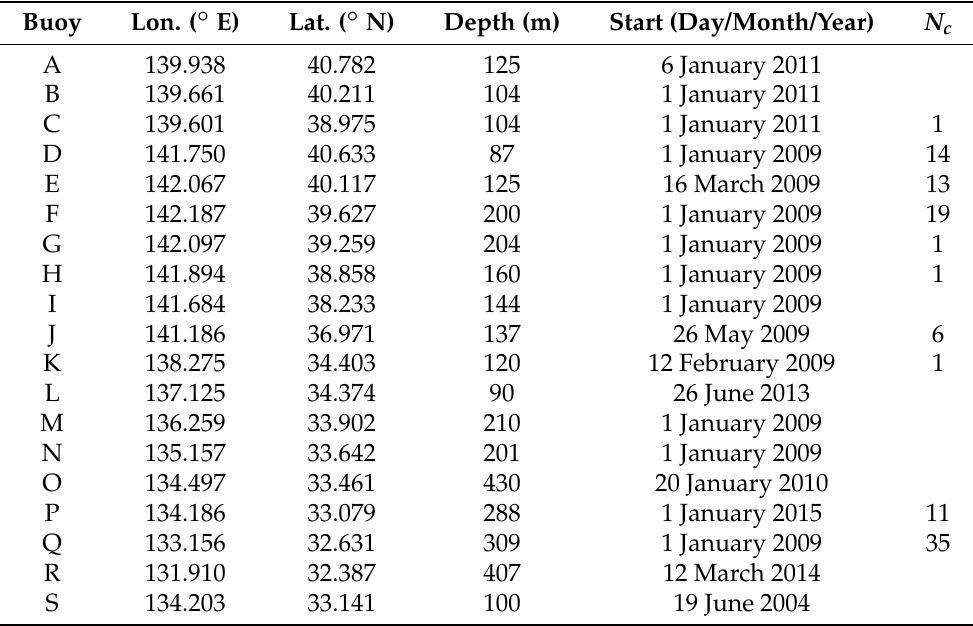
Table 1. Locations and observation start time of the moored GPS buoys, and number of comparisons ( N c ) with JMA buoys in Figure 2. Figure 1 show the locations of the GPS buoys. Buoy S provides wave data until